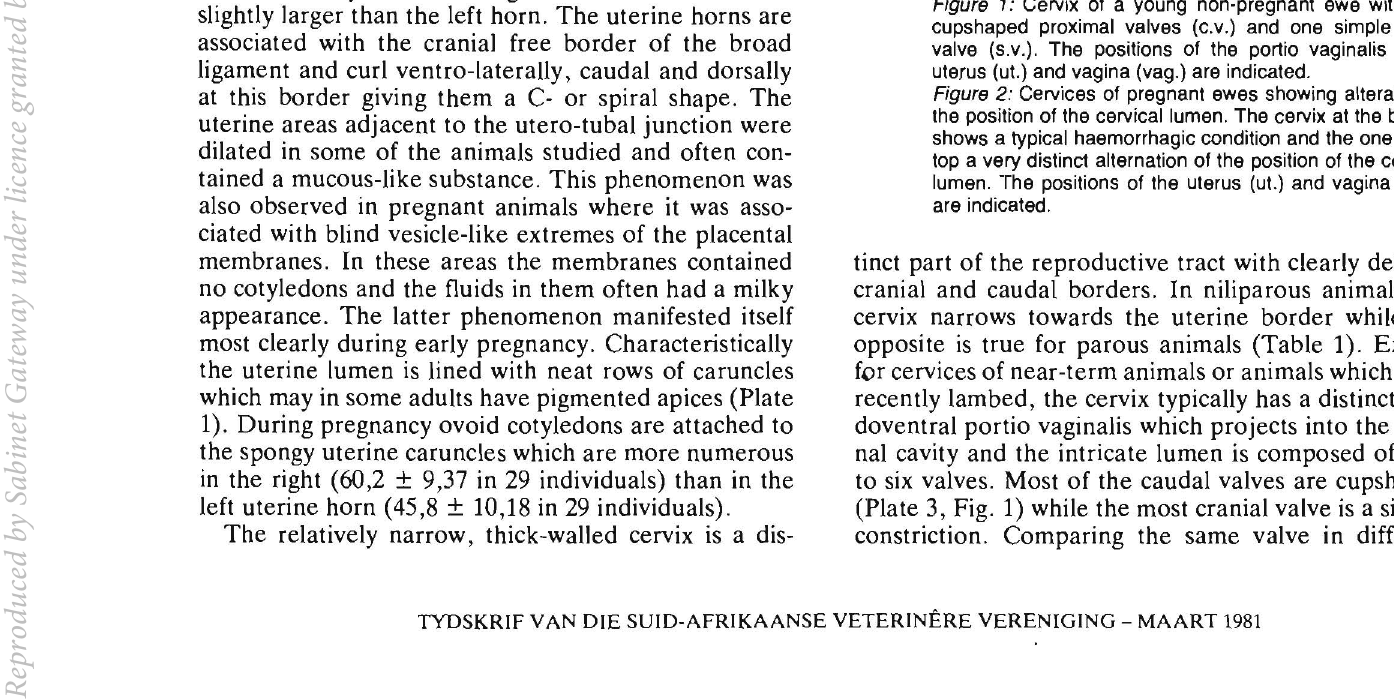
Figure 1: The complete ovarian bursa showing the posit· ions of the oviduct and the ostium fallopius as well as the ligaments of the ovary. Figure 2: The utero-tubal flexure typically displayed by all the female reproductive tracts. bu. - bursa; d.1. - diaphragmatic ligament; me. - mesova rium; 0.1. - ovarian ligament; os. - ostium fallopius; ov. - ovarium; ovi. - oviduct; ut. - uterus.